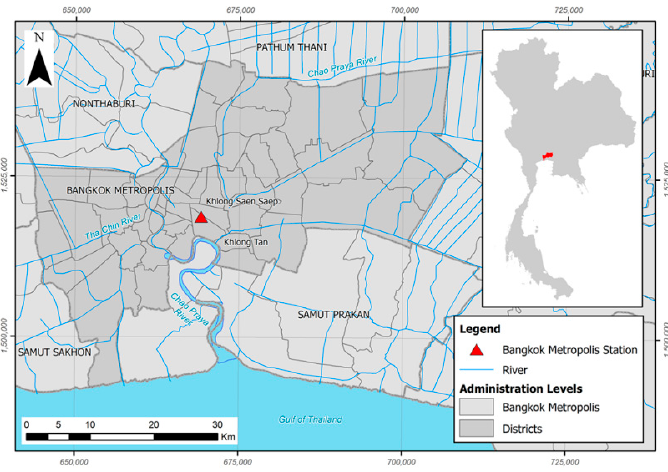
Figure 1. Location of the case study area: Bangkok, Thailand.